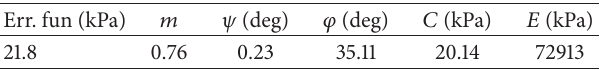
Table 2: The best set of parameters obtained by systematic inverse analysis via GA optimization